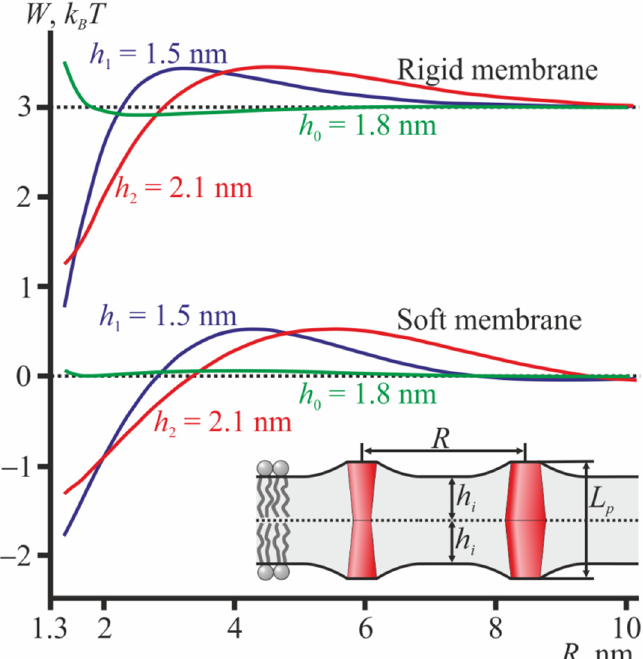
Figure 5. The interaction potentials of hourglass-like and barrel-like TMDs. Top set of curves—in the ordered (rigid) membrane; bottom set of curves—in the disordered (soft) membrane. Blue curves— h 1 = 1.5 nm; green curves— h 0 = 1.8 nm; red curves— h 2 = 2.1 nm. The top set of curves is shifted upwards by the constant 3 k B T to distinguish it from the bottom set of curves. The inset illustrates hourglass-like and barrel-like TMDs in the thin bilayer; L p = 2 h 0 = 3.6 nm.